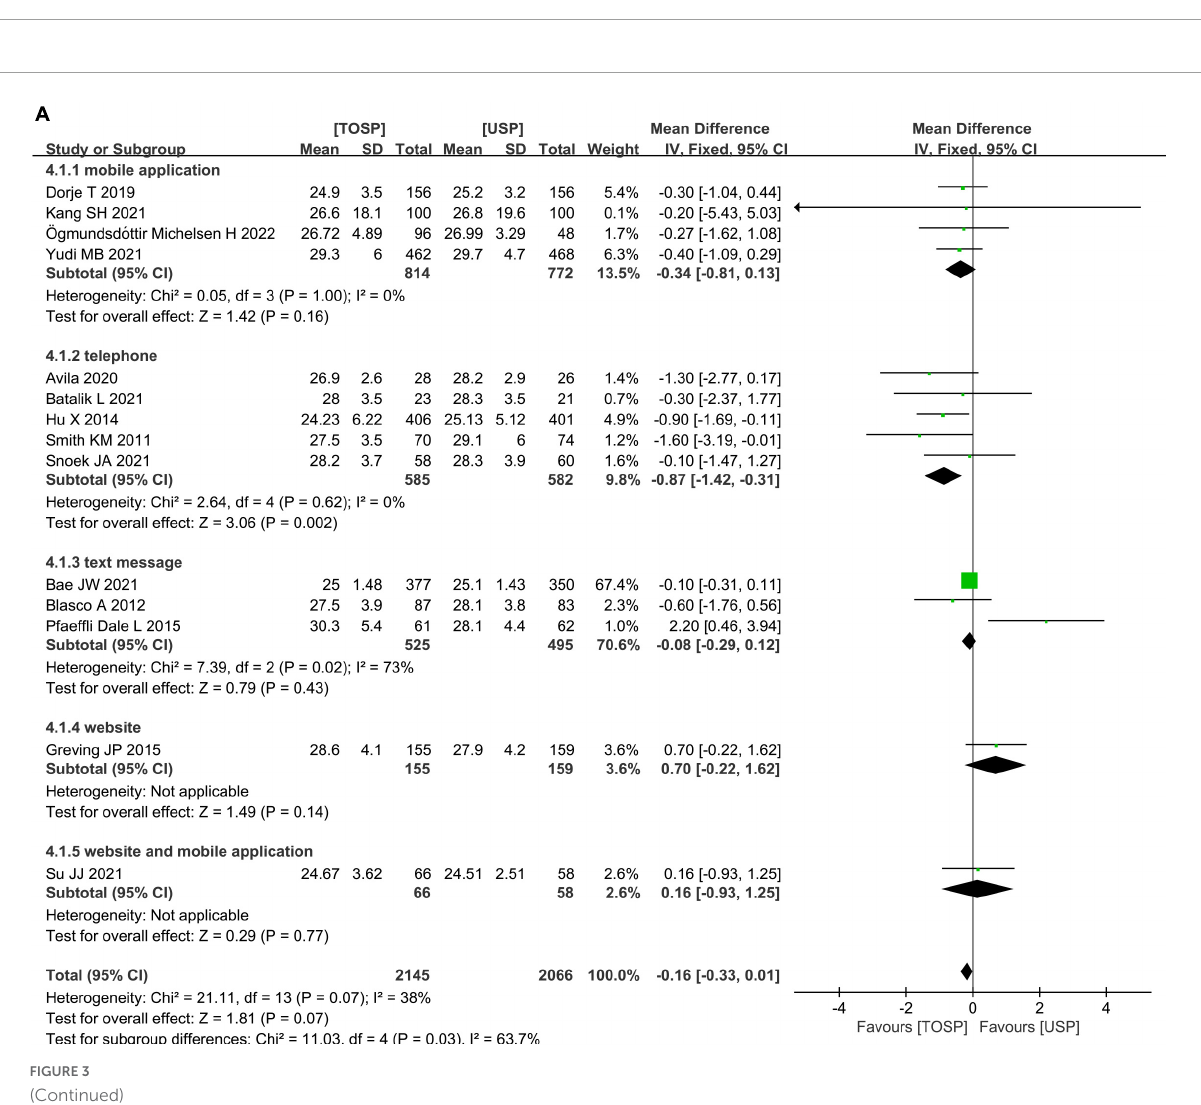
FIGURE2 Risk of bias assessment included